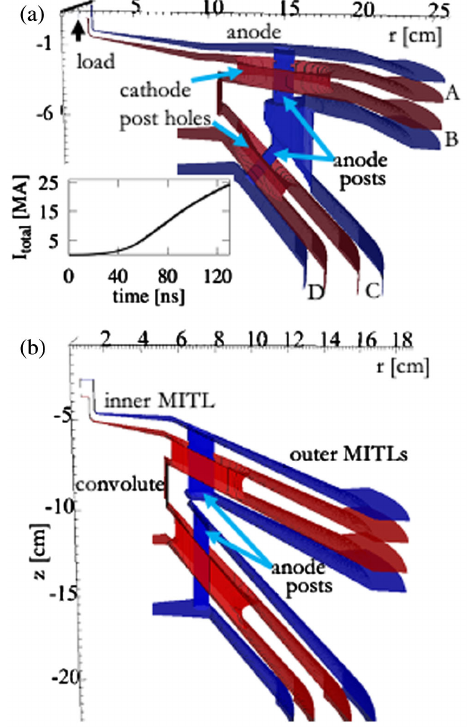
FIG. 2. Illustration of the outer MITLs, double post-hole convolute, and inner MITL fielded for (a) a ∅ 31 cm convolute and (b) a ∅ 15 cm convolute. A pulse-generating circuit is attached at the four outer MITL feeds labeled A, B, C, and D. The total current is inlaid in